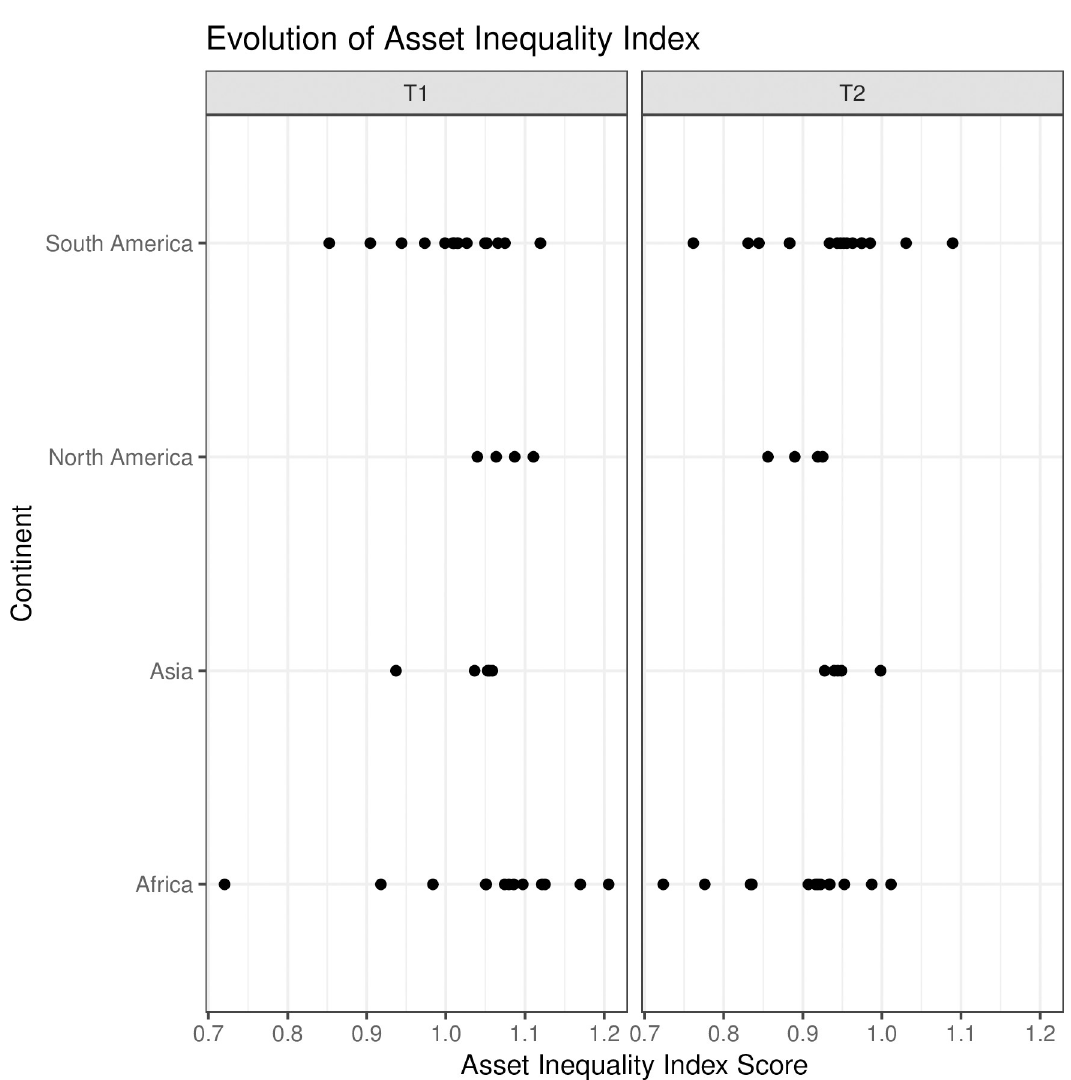
Fig 5. The development of the Asset Inequality Index by